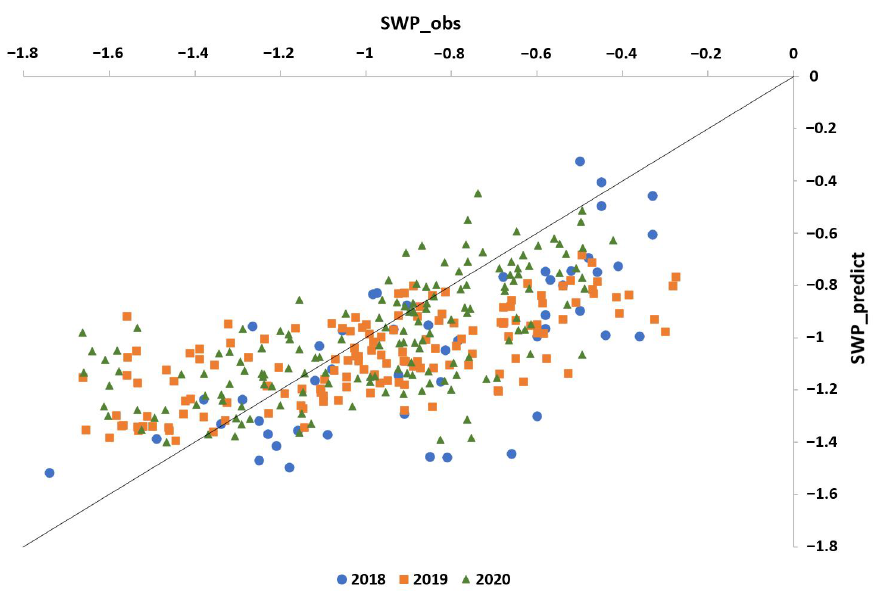
Figure 14. Data distribution according to study year.